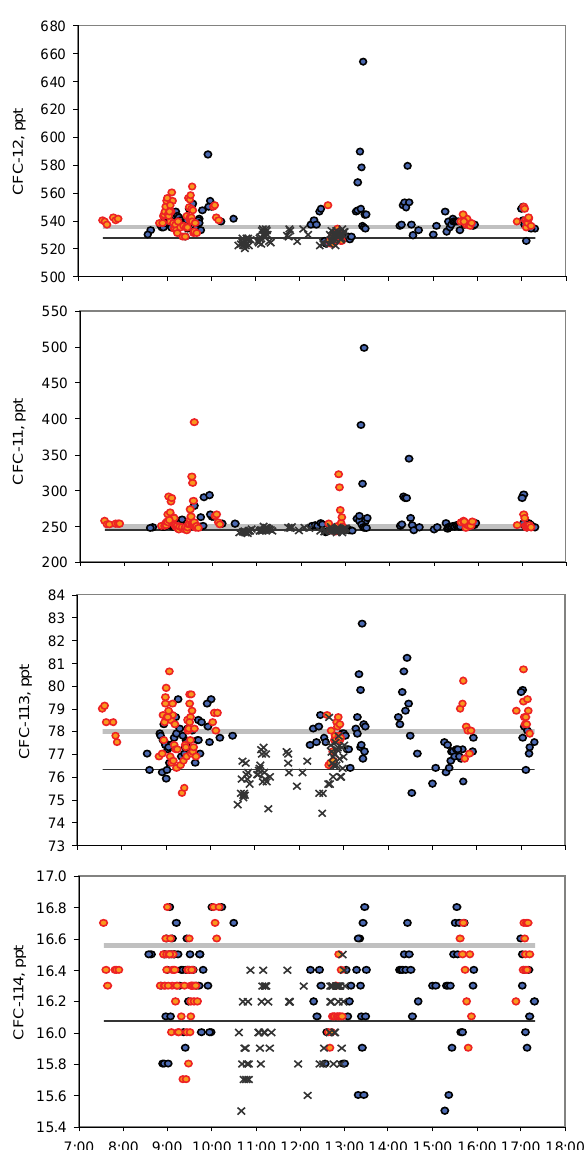
Fig. 3. Mixing ratio of CFCs in samples collected over the LA area (orange filled circles), the remaining SoCAB (blue filled circles), and offshore in the inflow air masses (black crosses). The black line indicates the average of the inflow, while the grey line represents the average plus two standard deviations.